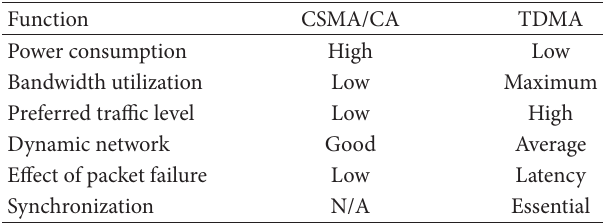
Table 2: Function comparison of CSMA/CA and TDMA [21].